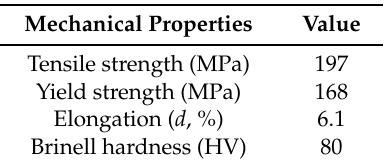
Table 2. Mechanical properties of A356 alloy at room